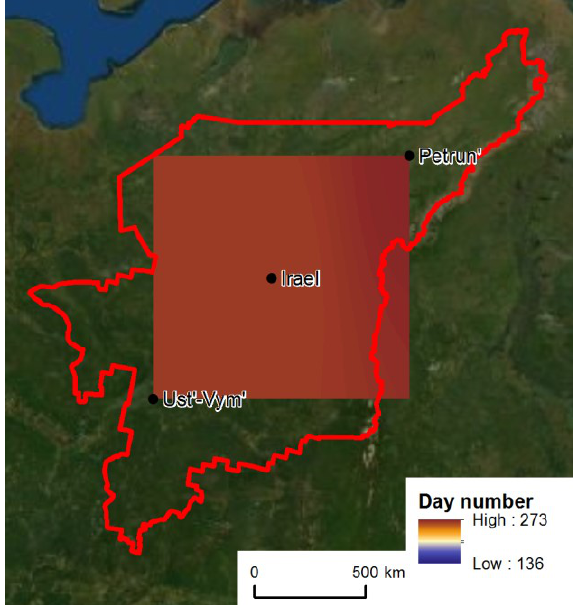
Figure 6. Beginning days of summer growing season interpolated between meteorological stations